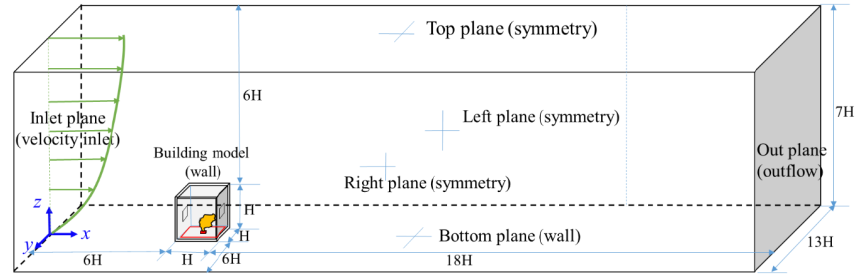
Figure 2. Computational domain and boundary conditions.